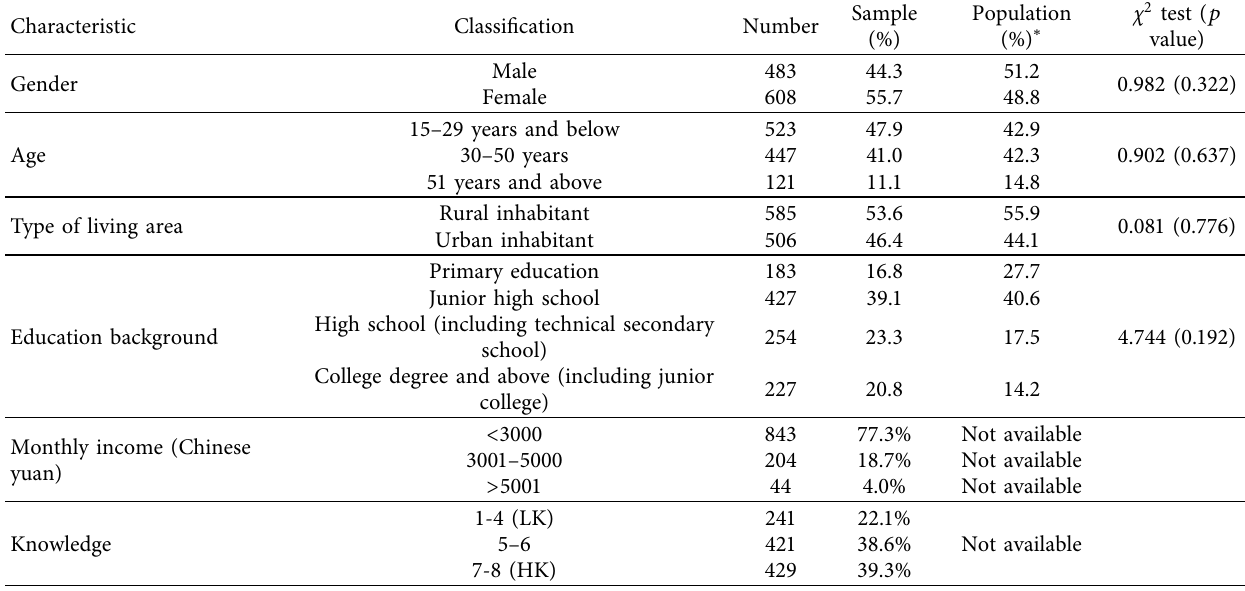
Table 4: Descriptive statistics of the sample.